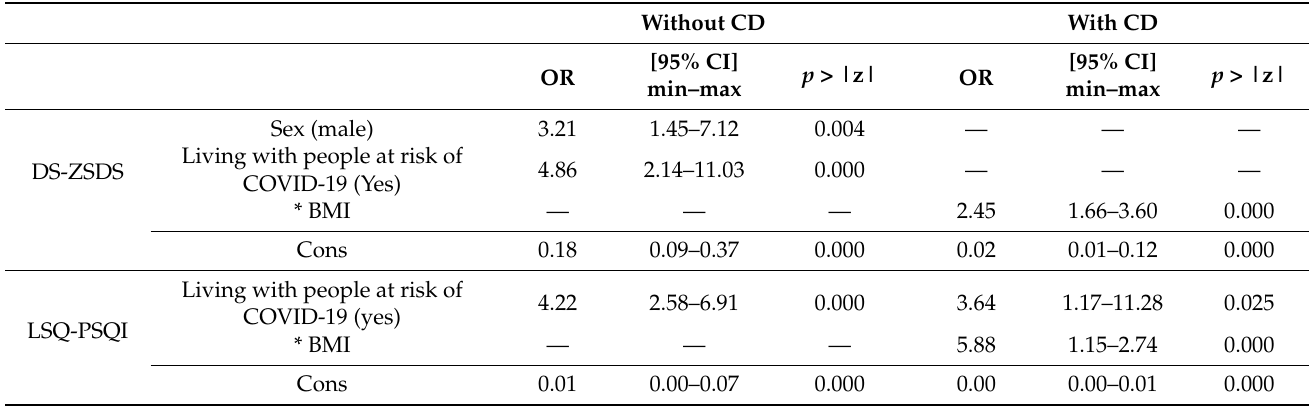
Table 4. Final multiple logistic regression model for DS (ZSDS) and LSQ (PSQI) in people with and without CD. Without CD With CD [95% OR